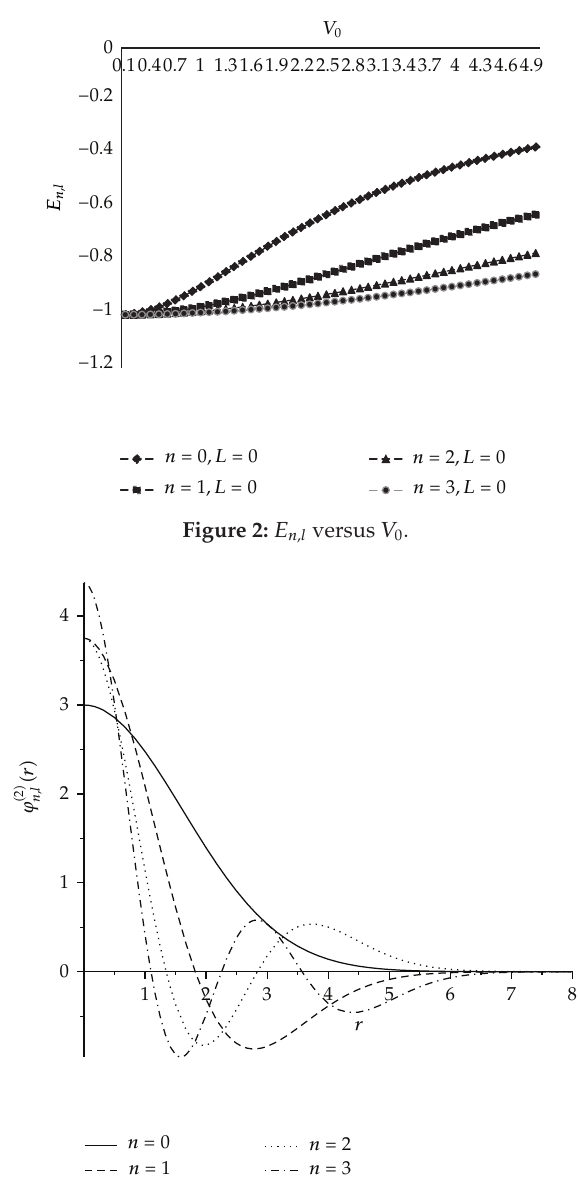
Figure 3: Wave functions for harmonic oscillator potential versus r for (cid:3) m 0 (cid:9) 1, α (cid:9) 0 . 1, and l (cid:9) 0 (cid:5)